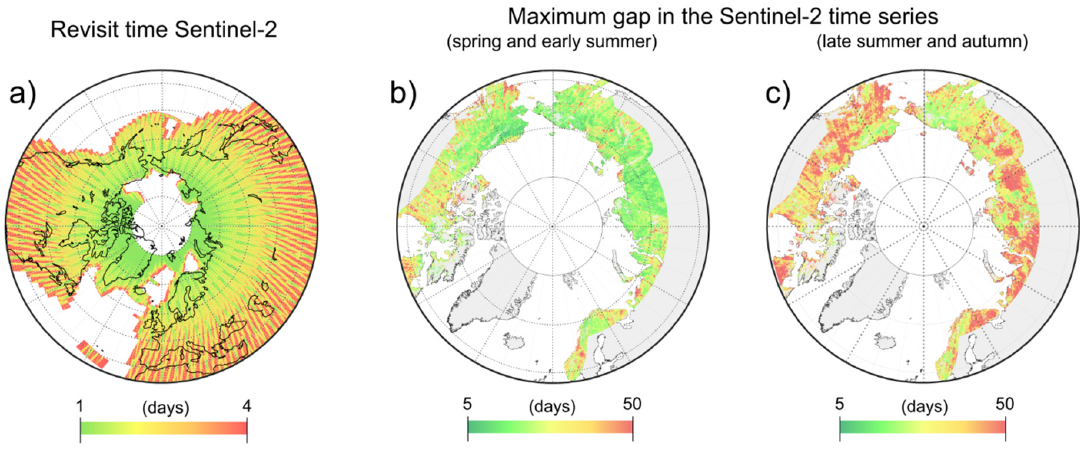
Figure 1. Revisit time of Sentinel-2 ( a ) and maximum discontinuity in the Sentinel-2 Level 2A time series after cloud masking for spring and early summer (1 May to 15 July) ( b ) and late summer and autumn (15 July to 30 September) 2019 ( c ).